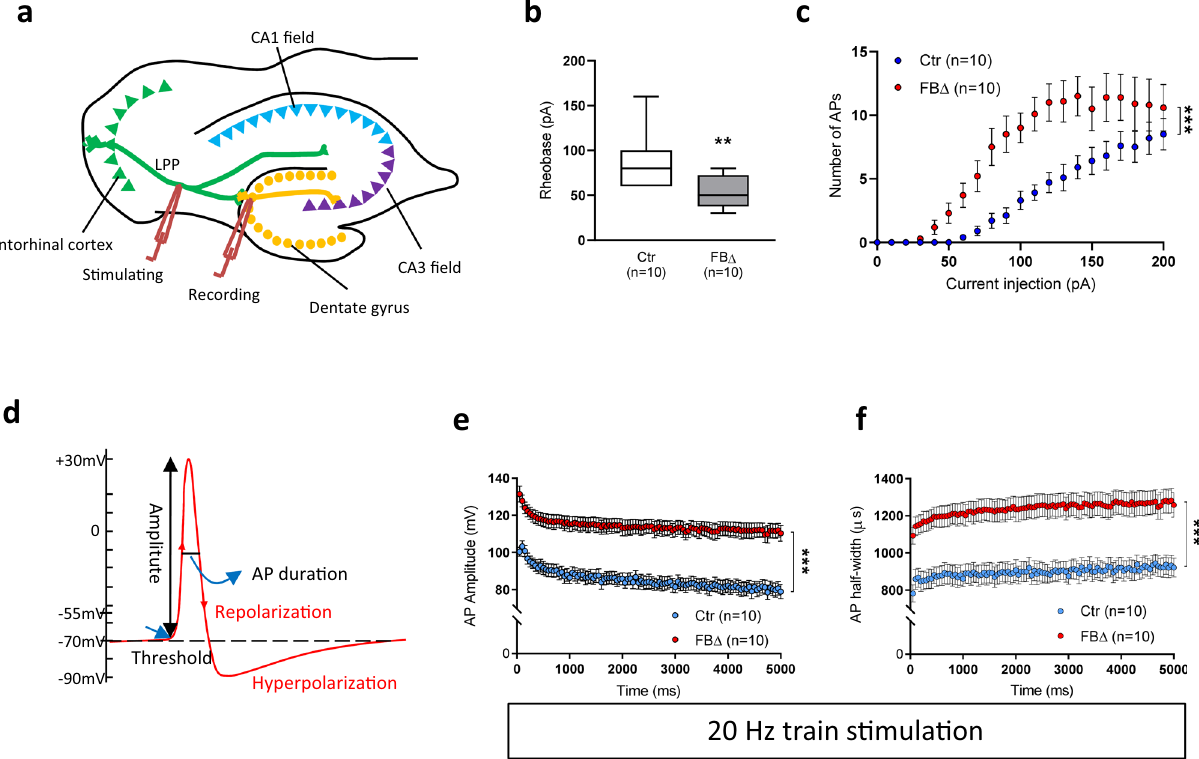
Fig. 5 ATR-deleted neurons are more excitable. a Schematic representation of hippocampal electrophysiology measurements on lateral perforant pathway (LPP)-dentate gyrus granule cell synapses. b Rheobase current of 1st provoked action potential by increasing stimulation in control (Ctr) and ATR- FB Δ (FB Δ ) neurons. Box plot indicates the median (middle line), whiskers as max value (top) and min value (bottom) and hinges as 25 percentile (top) and 75 percentile (bottom). MWU test (unpaired, two-tailed), p = 0.007. ** p < 0.01. c Number of action potentials (AP) in granule cells of the dentate gyrus in control ( n = 10) and ATR-FB Δ neurons ( n = 10) after 1000 ms current stimulation steps of 0 to 200 pA. Error bars indicate SEM. 2-way ANOVA with Holm-Sidak Post Hoc Analysis. *** p < 0.001. d Schematic representation of analysis on AP properties. e AP amplitudes within 20 Hz AP train. Error bars indicate SEM. 2-way ANOVA with Holm-Sidak Post Hoc Analysis. *** p < 0.001. f Plot of half-height width of AP in whole-cell recorded dentate gyrus granule cells within the 20 Hz train stimulation. Error bars indicate SEM. 2-way ANOVA with Holm-Sidak Post Hoc Analysis. *** p < 0.001. b , c , e , f The number of neurons measured is indicated within the graph. Source data are provided as a Source Data fi